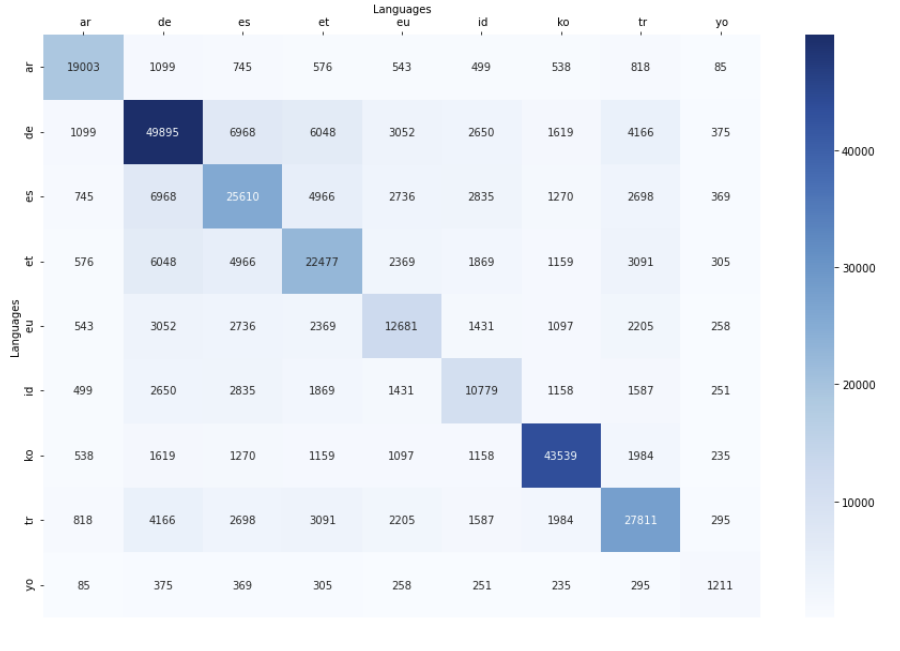
Figure 7. Coincidences between languages: number of